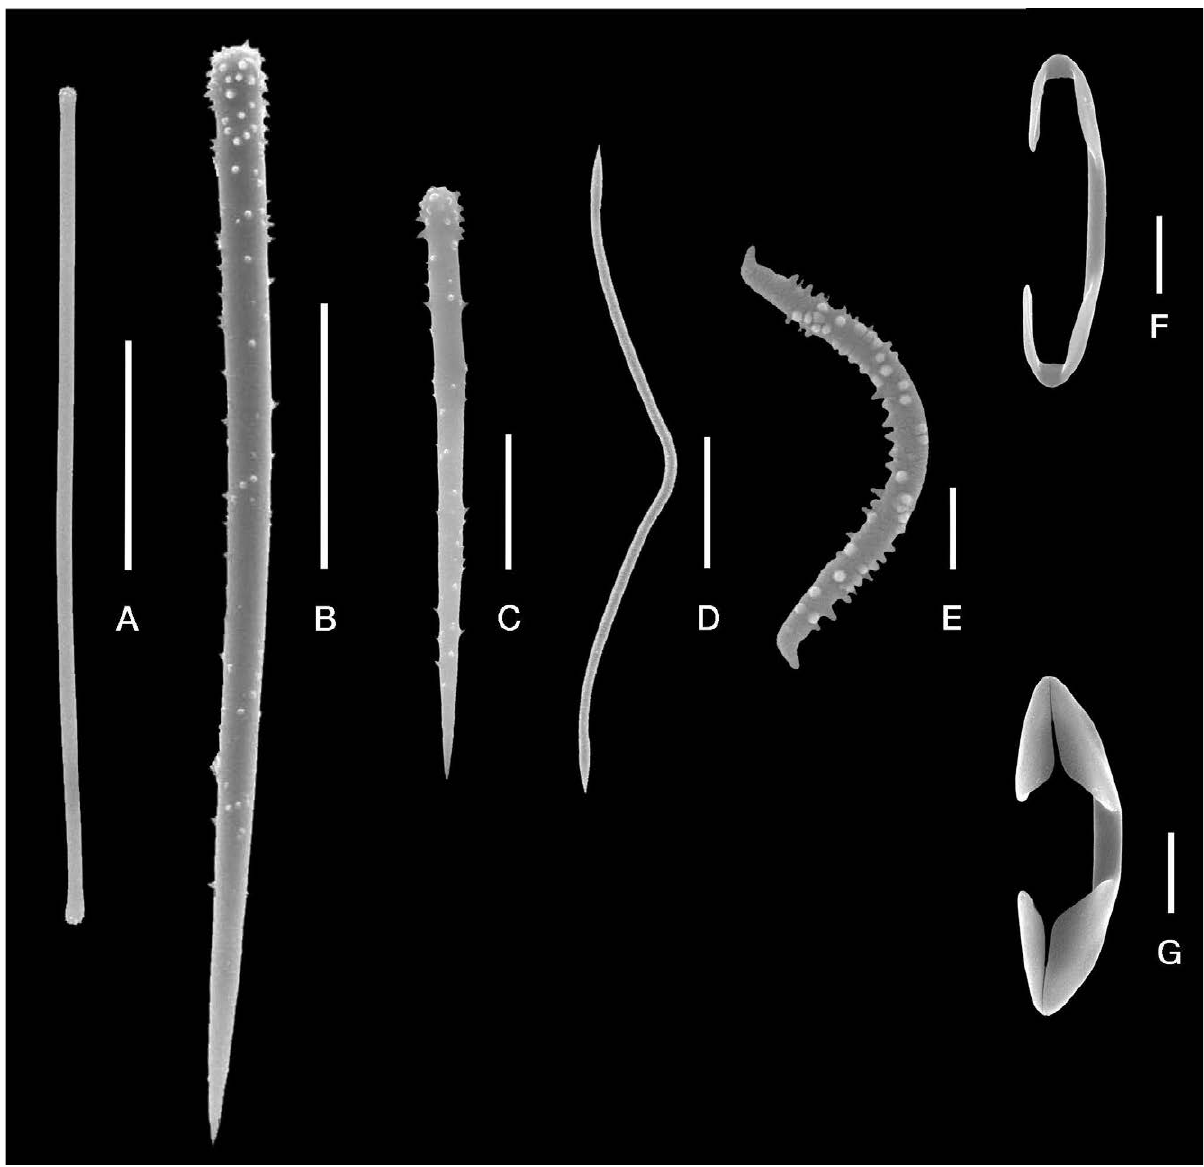
Fig . 11. – Megaciella toxispinosa n. sp. A, Ectosomal tylote with microspined heads. B, Choanosomal acanthostyle. C, Echinating acantho- style. D, Wing-shaped toxa. E, Microspined toxa. F, Palmate isochela with the alae reduced. G, Palmate isochela with the alae fused to the shaft. Scale: A, 50 μm; B, 70 μm; C, 20 μm; D, 7.5 μm; E, 1 μm; F, 2.5 μm; G, 3.5